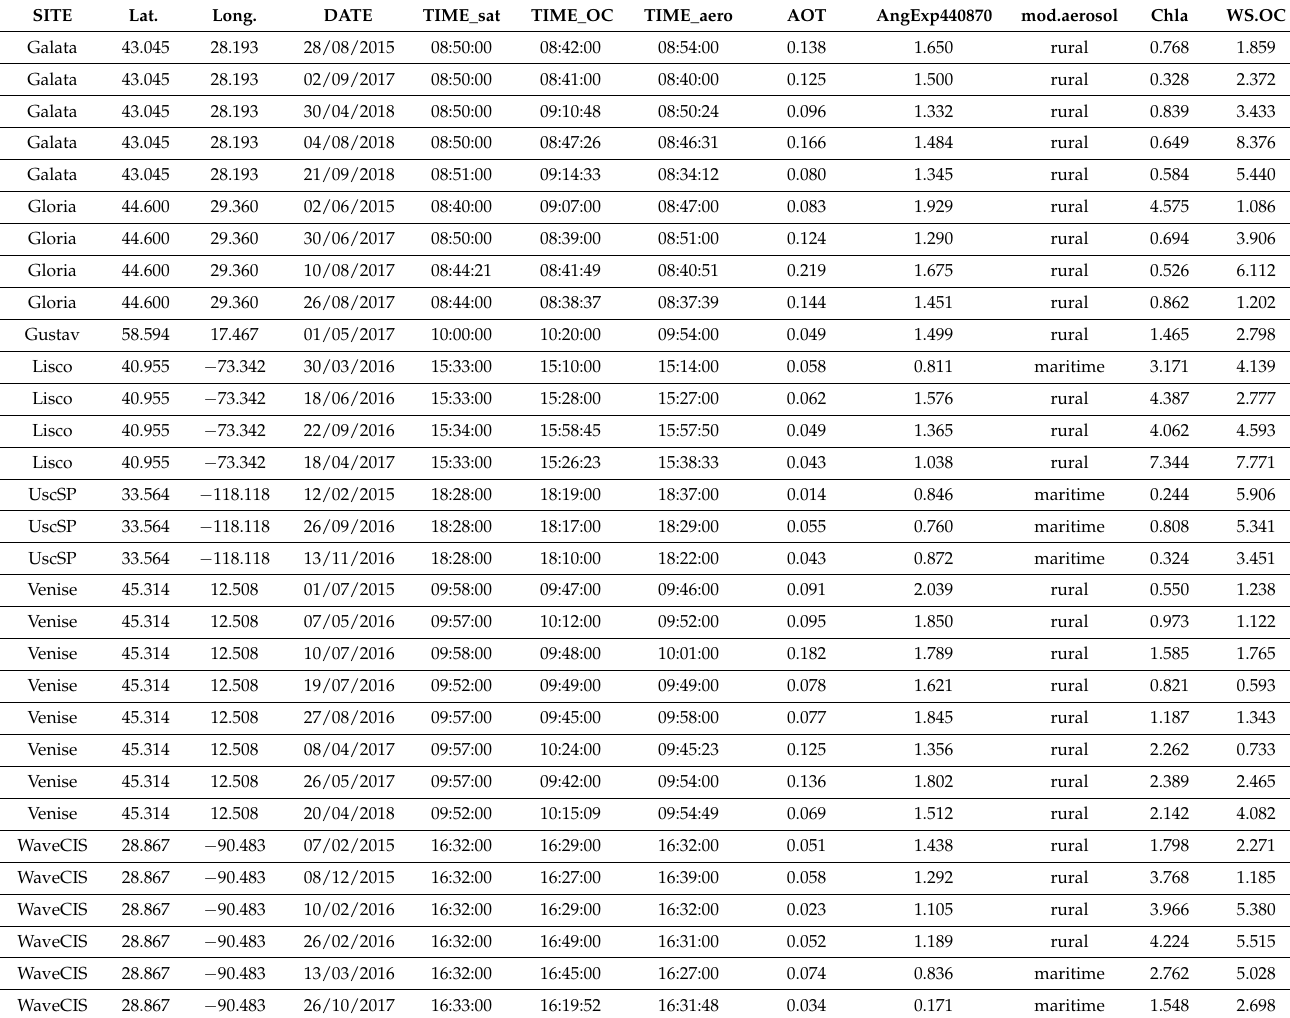
Table 1. Dataset of the OLI/L8 images acquired over the AERONET-OC stations with quasi-synchronous AERONET- OC products.